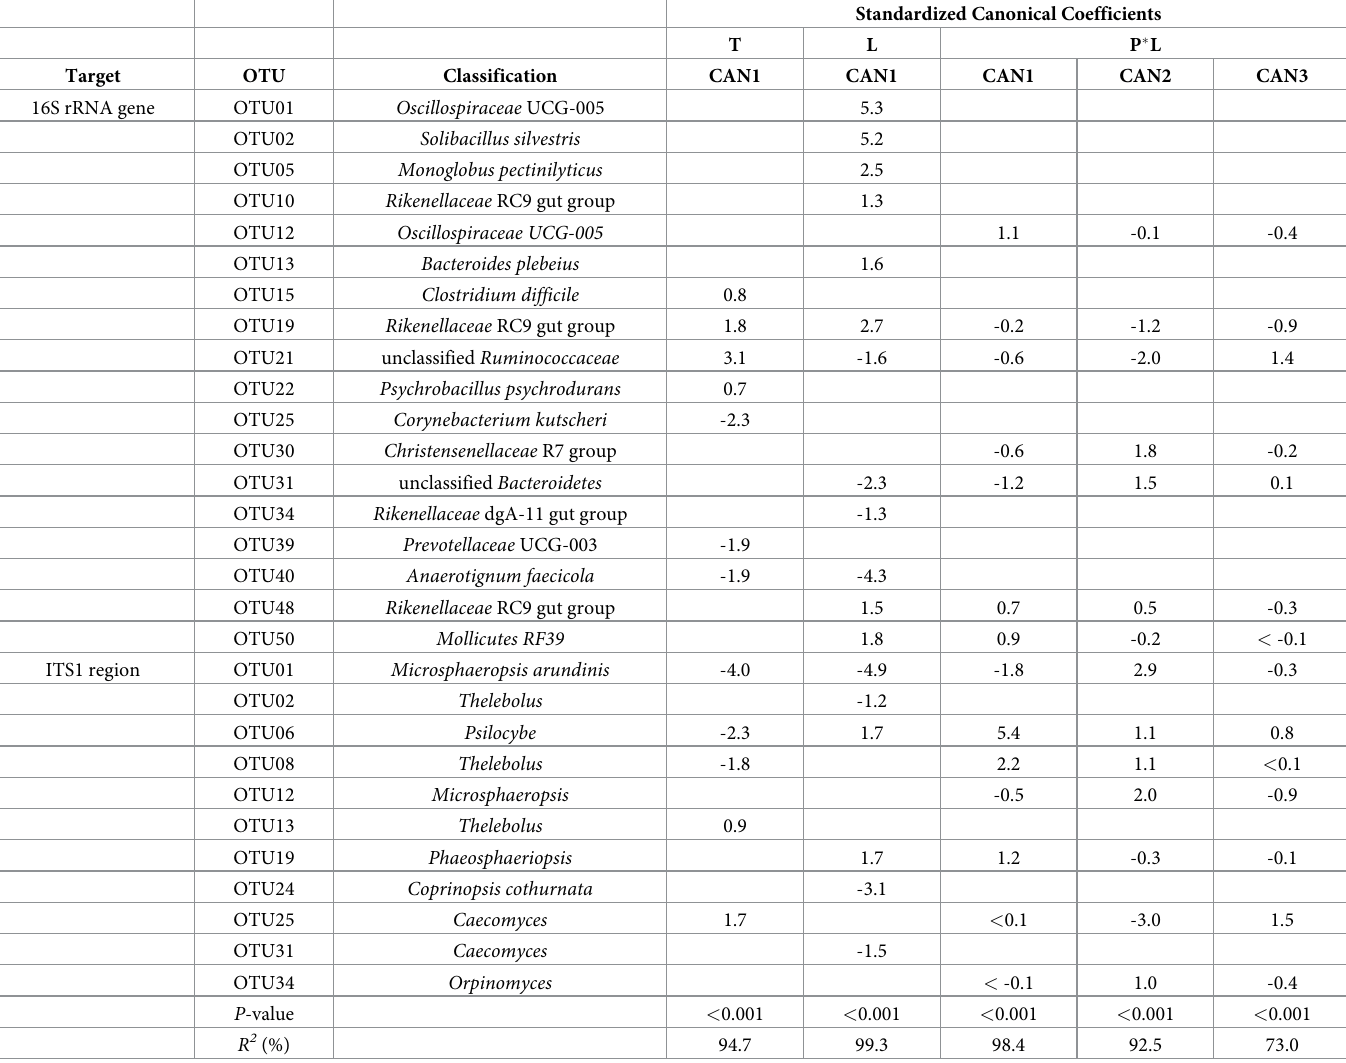
Table 4. Canonical discriminant analysis for tolerance group 1 (T), Location 2 (L), and interaction between T and L (T �